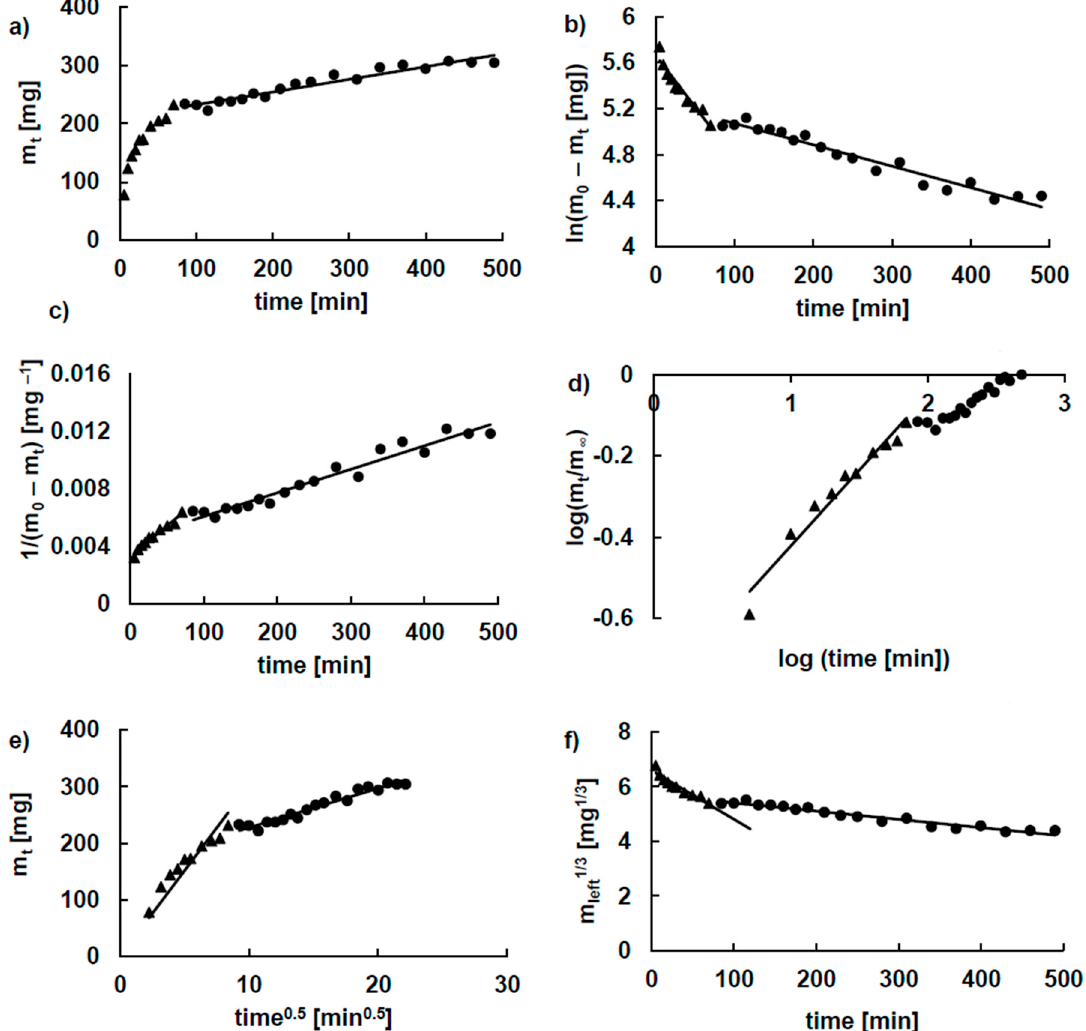
Figure 5. Kinetics of the release of 5 ‐ ASA from formulation F8 according to ( a ) zero ‐ order, ( b ) first ‐ order, ( c ) second ‐ order, ( d ) Korsmeyer–Peppas ( e ) Higuchi ( f ) Hixon–Crowell model; experimental points of the first stage are marked ▲ and of the second stage ● , the line is the guide for the eye.